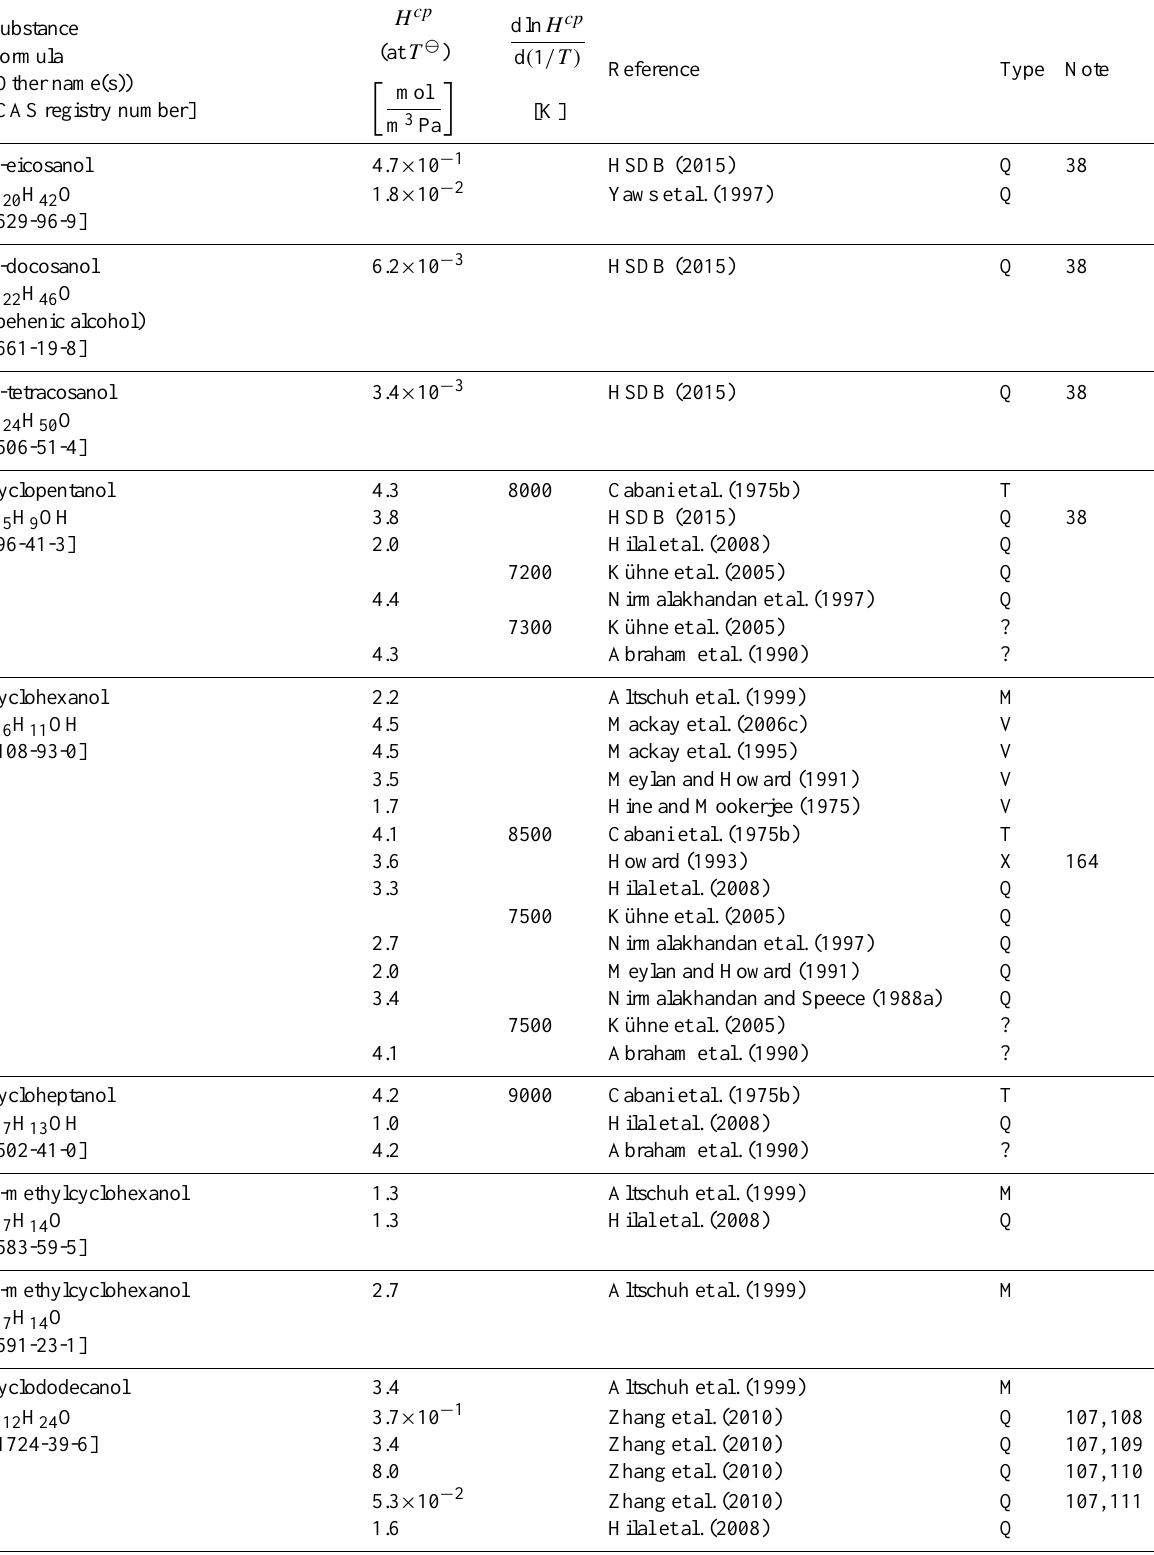
Table 6: Henry’s law constants for water as solvent